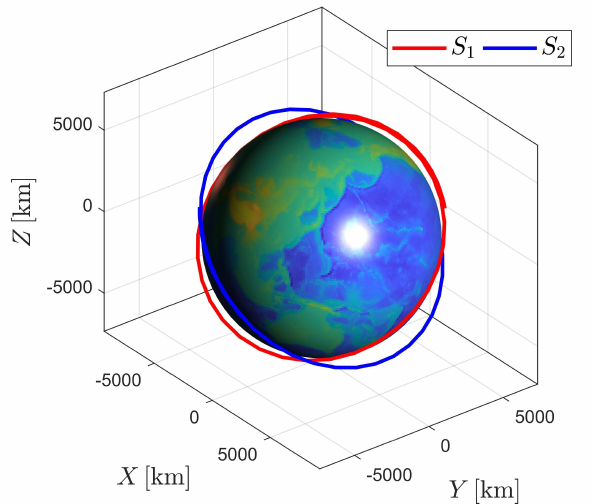
Figure 2. Orbits of spacecraft S 1 and S 2